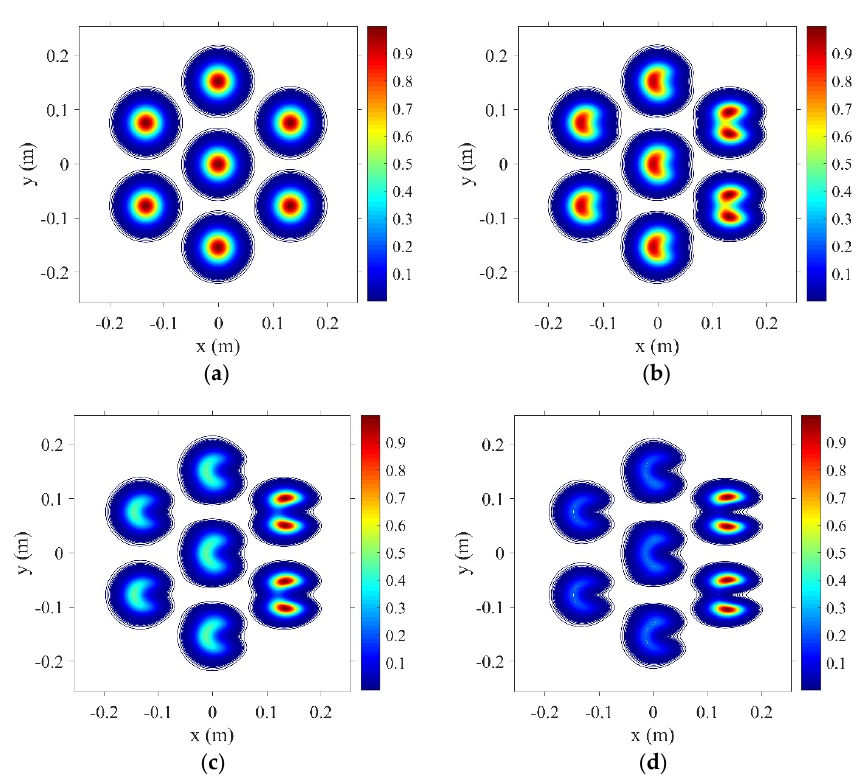
Figure 6. Thermal blooming of 7 − incoherent beams, where ( a ) Initial arrangement; ( b ) N c = 0.5; ( c ) N c = 1.0 and ( d ) N c = 1.5.